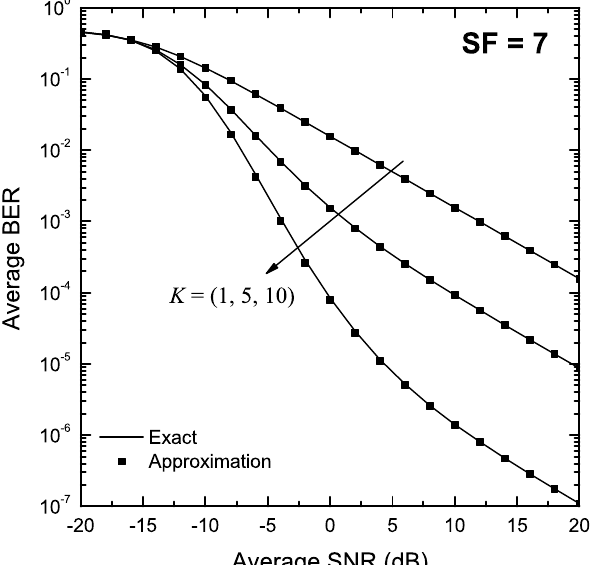
Figure 4. BER of LoRa systems operating in the presence of Rice fading as a function of the SNR, γ , for SF = 7 and various values of K